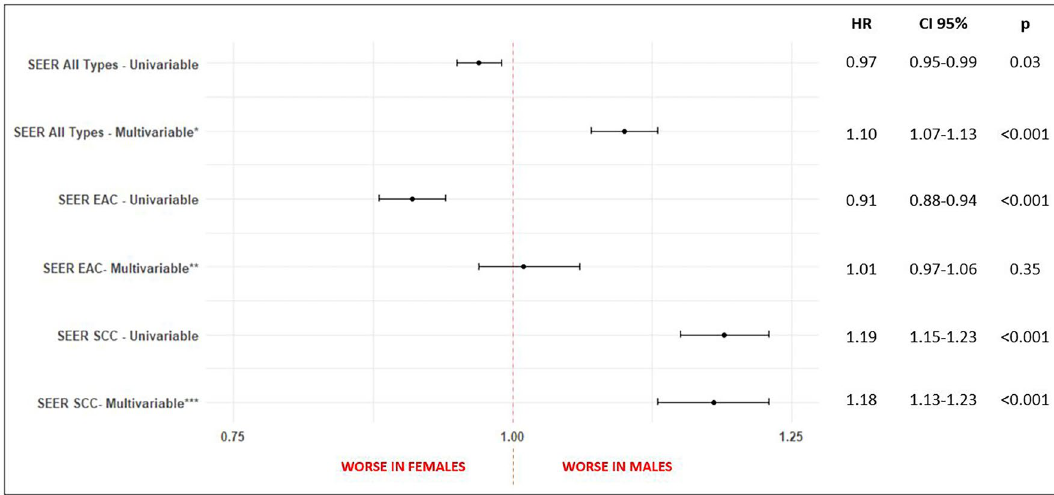
Figure 7. Forest plot of sex differences in survival for esophageal cancer (all types), esophageal adenocarcinoma (EAC) and squamous cell carcinoma (SCC). Univariable and multivariable cox models represented, SEER Database (2005–2018). *Adjusted for: age at diagnosis, race, ethnicity, histology, stage, chemotherapy, radiotherapy, and surgery. **Adjusted for: age at diagnosis, race, ethnicity, stage, chemotherapy, radiotherapy, and surgery. ***Adjusted for: age at diagnosis, race, histology, stage, chemotherapy, radiotherapy, and